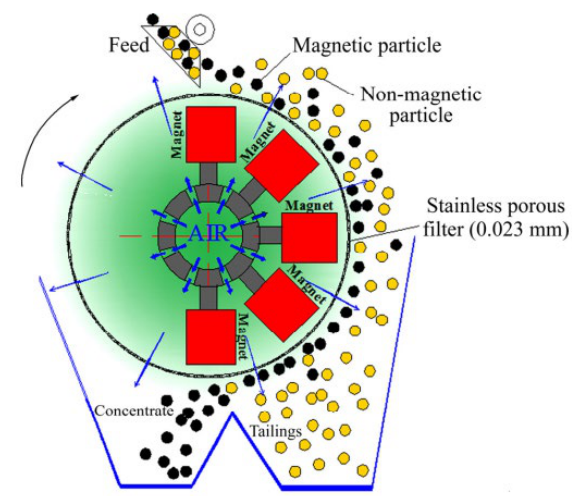
Figure 12. New type of wind dry-type magnetic separator [51].